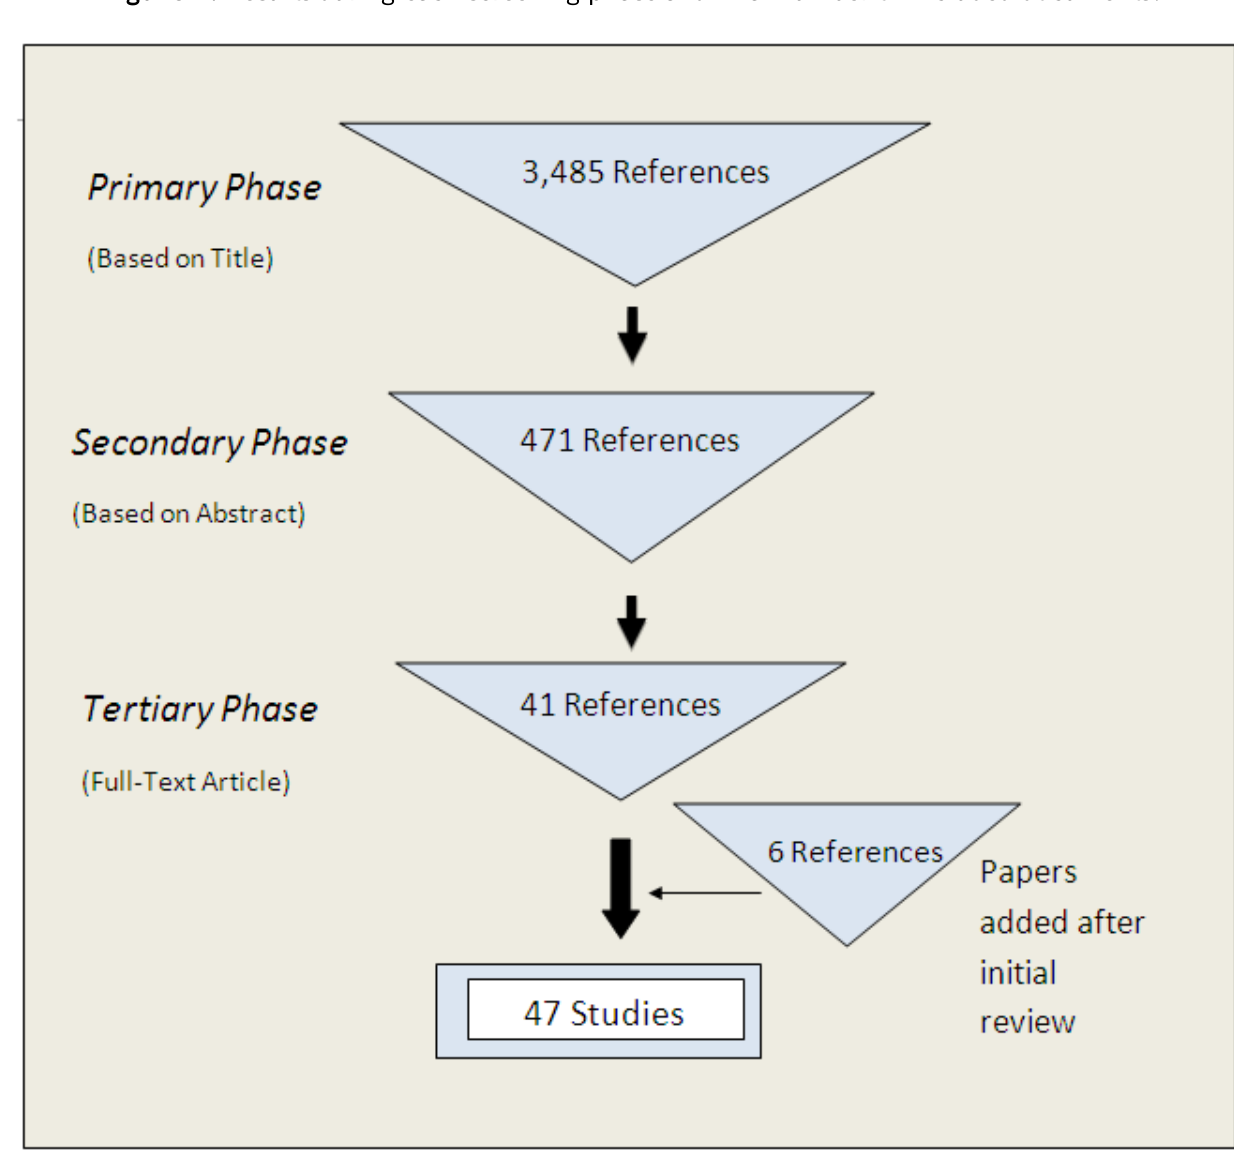
Figure 1. Results during each screening phase and final number of included documents.